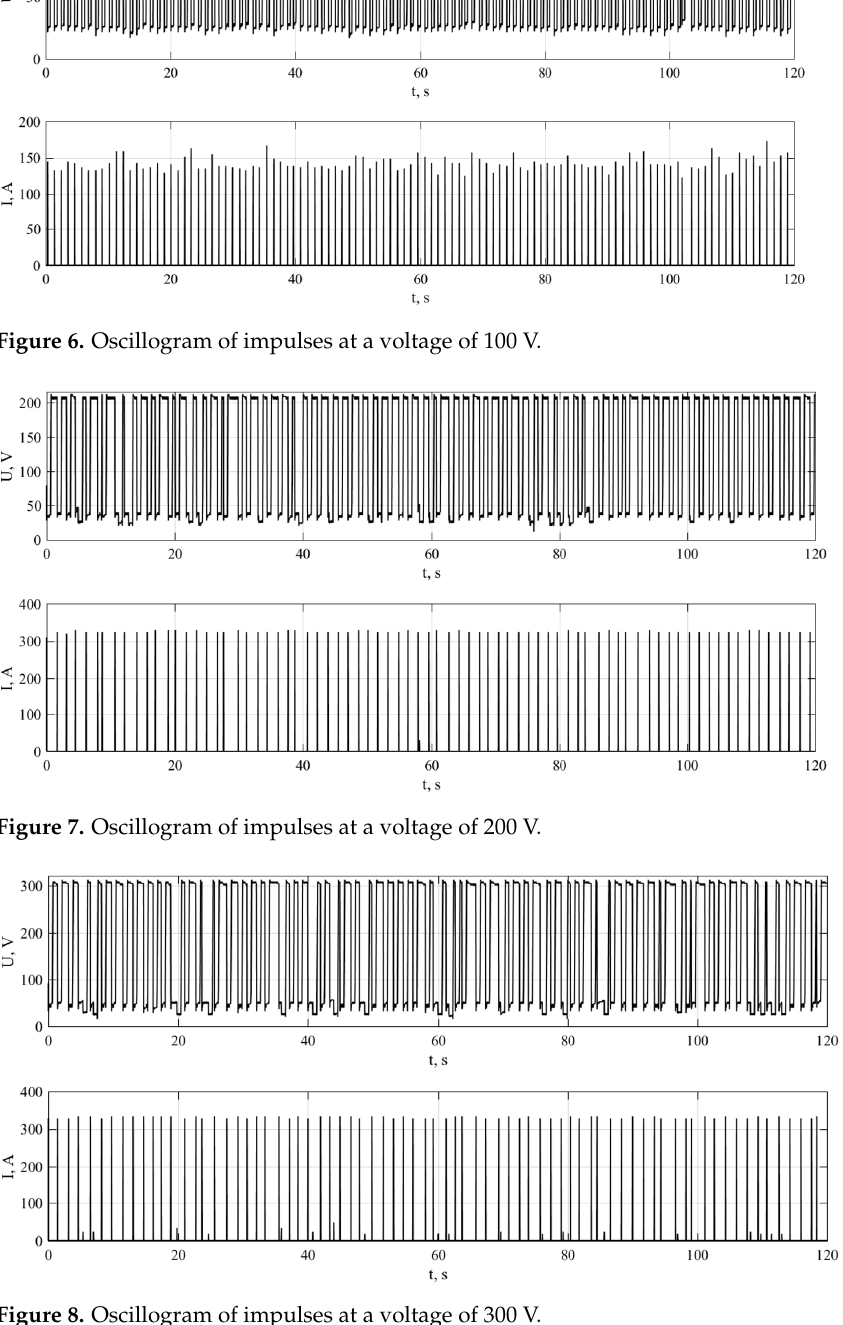
Figure 8. Oscillogram of impulses at a voltage of 300 V.